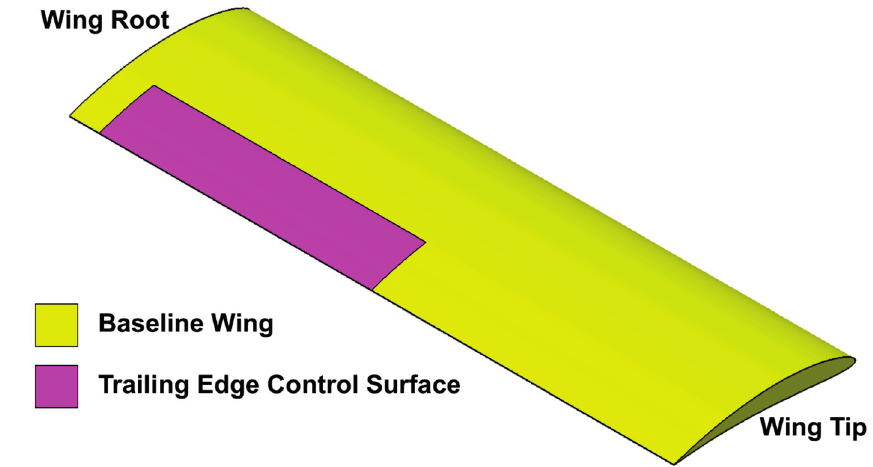
Figure 1. Baseline wing